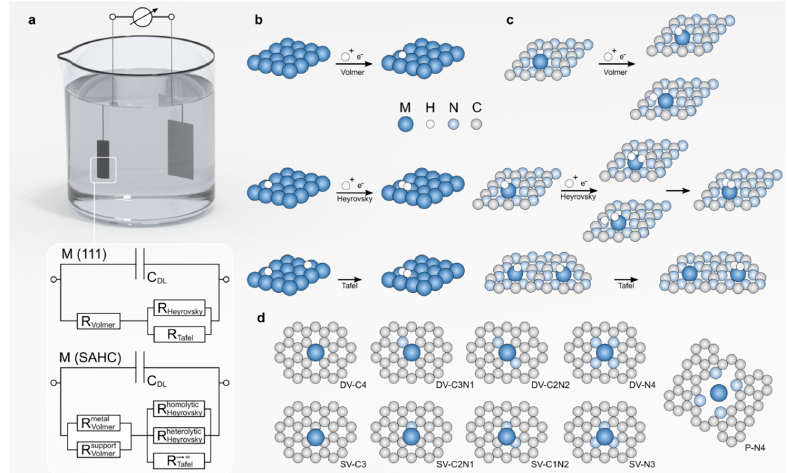
Figure 7. Equivalent circuit of the anodic part of an electrolyzer depending on the speciation of the active metal phase ( a ). Schematic representation of crucial hydrogen evolution steps in protic acidic medium on an extended (111) surface of an fcc metal ( b ) and a typical [179] Single Atom Heterogeneous Catalyst (SAC) (Pd atoms supported on heptazinic carbon nitride) ( c ). Coordination environments ( d ) of successful single atom HER catalyst described in the literature [180–186].